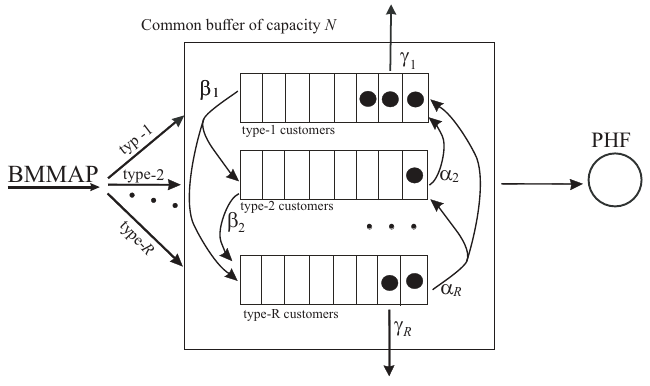
Figure 1. Structure of the